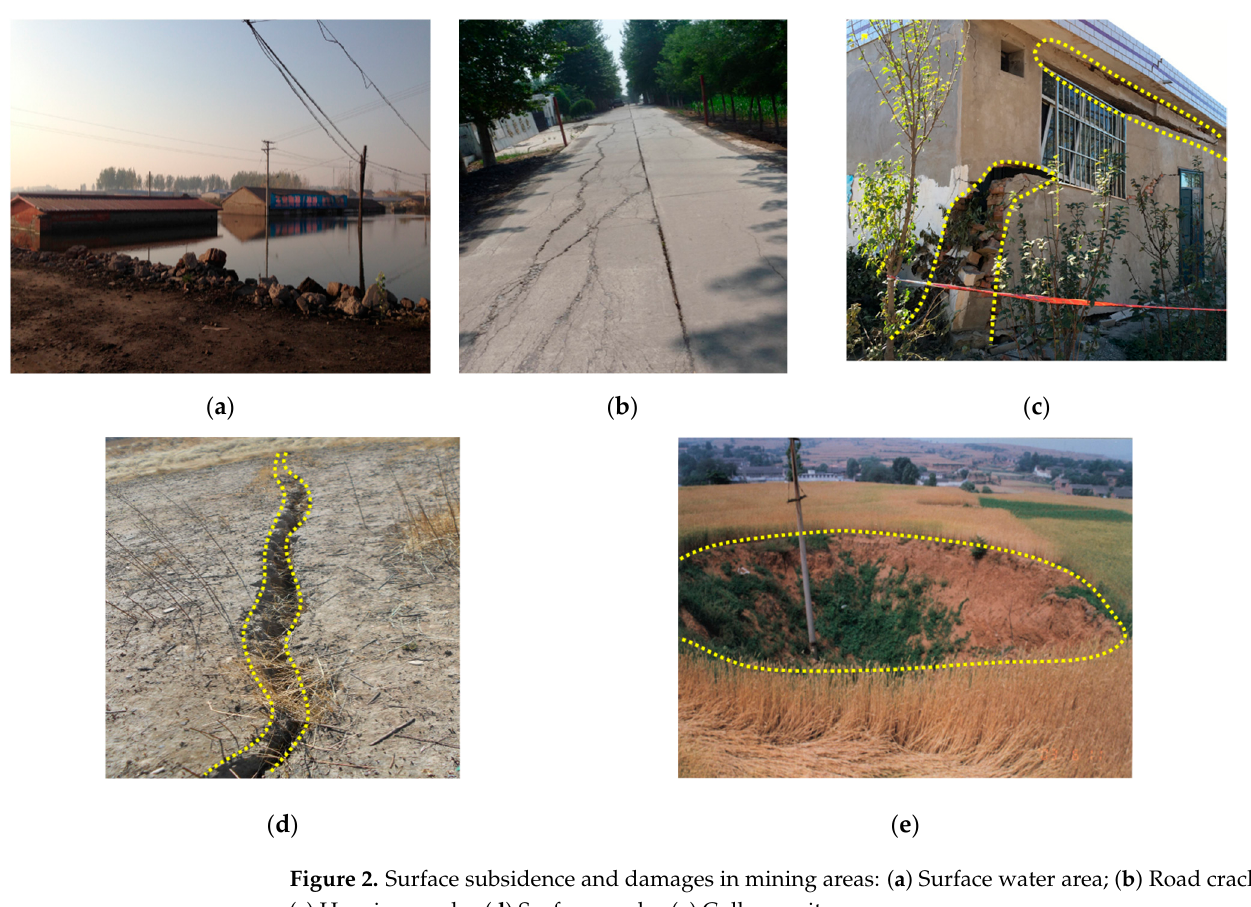
Figure 2. Surface subsidence and damages in mining areas: ( a ) Surface water area; ( b ) Road cracks; ( c ) Housing cracks; ( d ) Surface cracks; ( e ) Collapse pits.